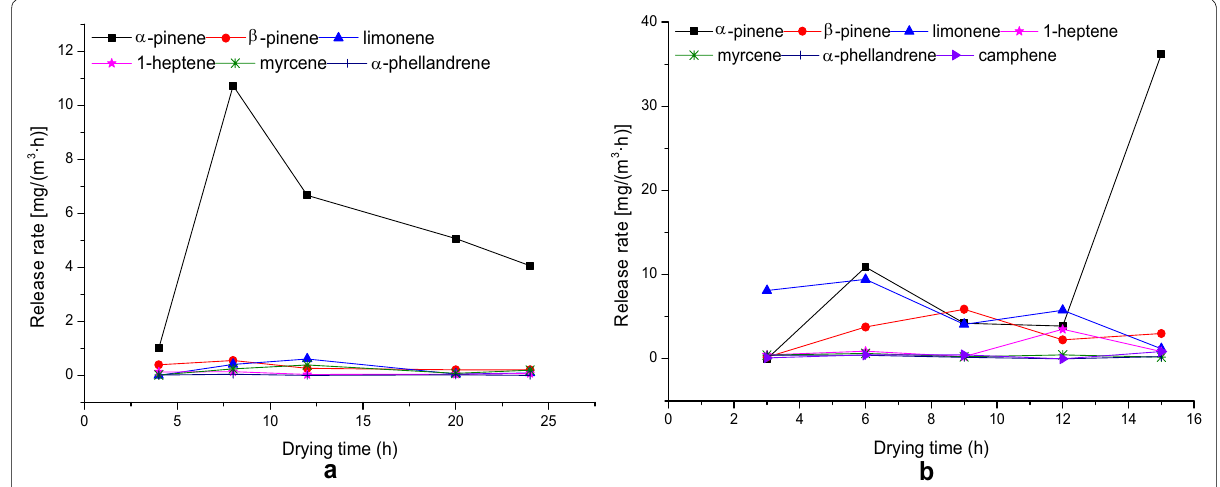
Fig. 7 Variations of release rate of terpene VOCs during a conventional drying, and b high-temperature drying for the Russian Pinus